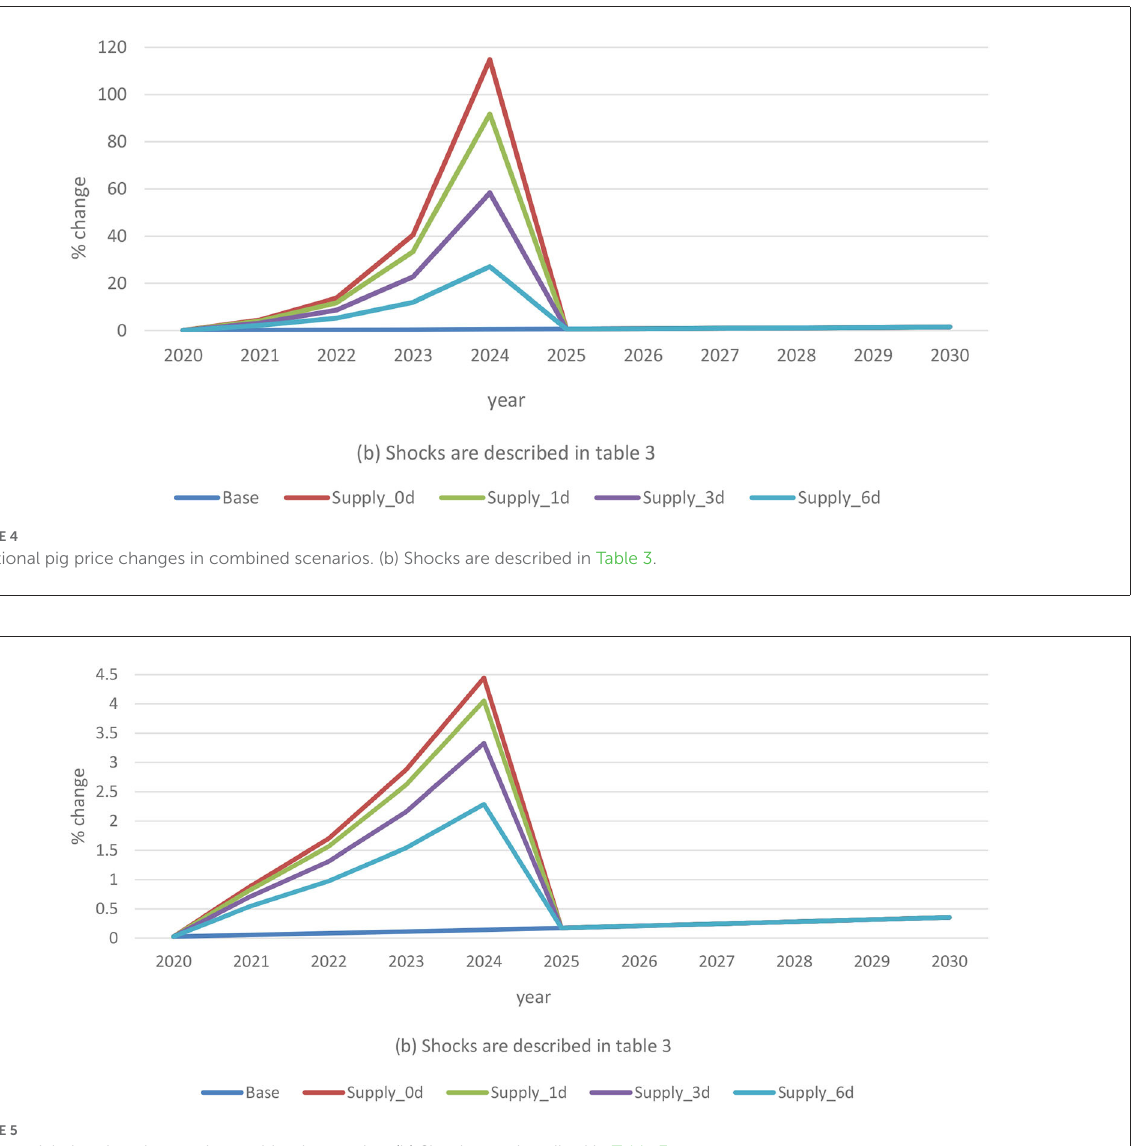
2.22% to 66% in 2024 compared to the 2019 base